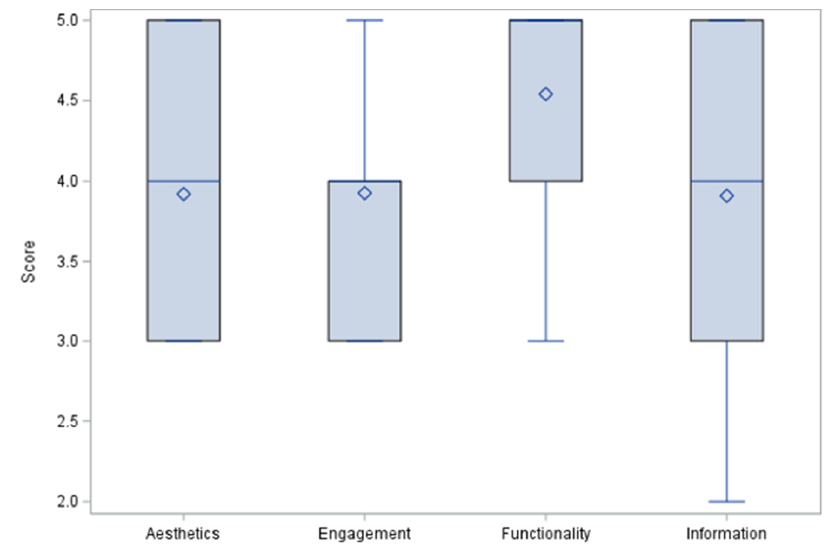
Figure 2. MARS tool category scores.